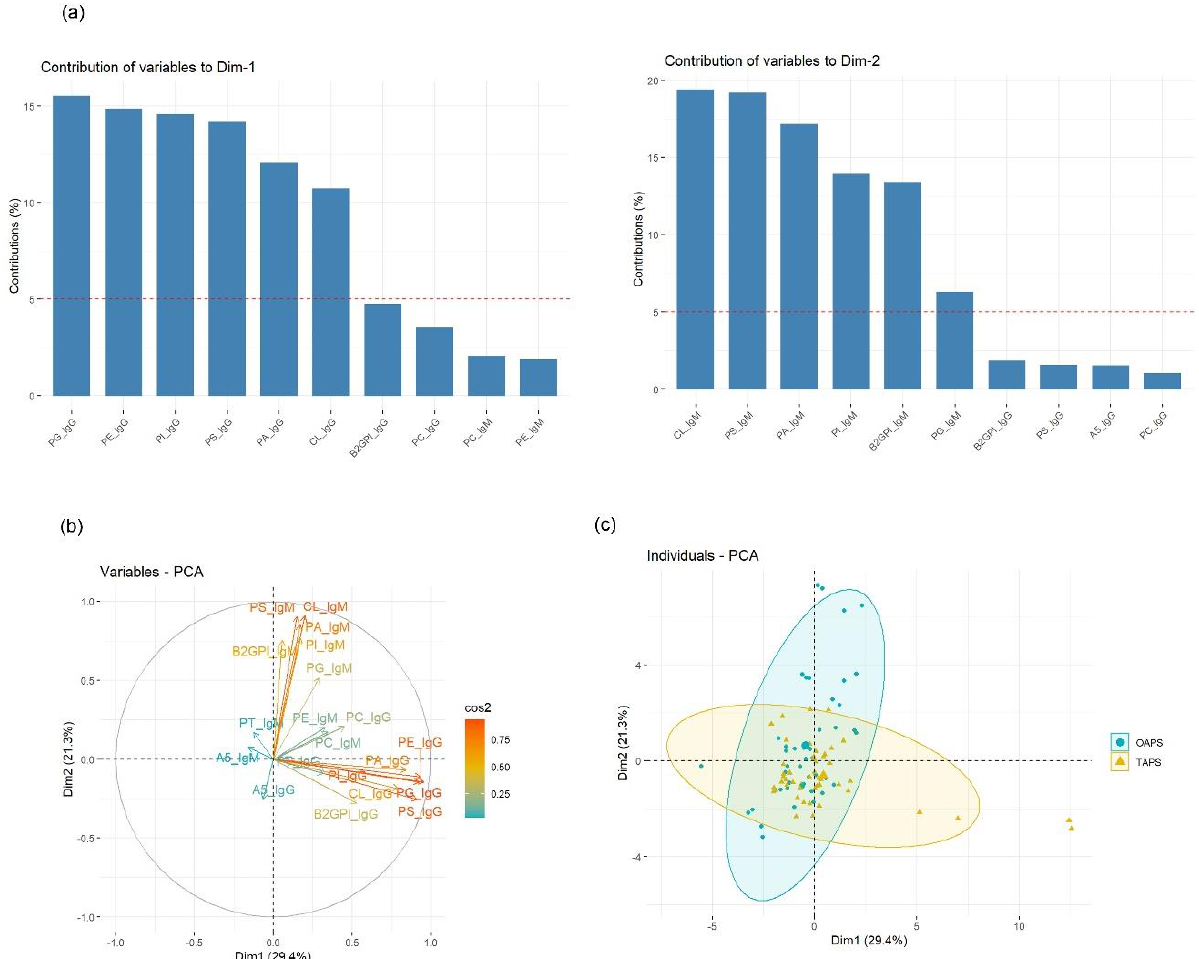
Figure 4. Antiphospholipid antibody (aPL) clustering for obstetric (OAPS) and thrombotic antiphos- pholipid syndrome (TAPS) patients. A principal component analysis (PCA) of logistic regression by using the R packages FactoMineR and factoextra was run. ( a ) The histograms show the selected variables and their value of contribution to define Dimension 1 ( x -axis) and Dimension 2 ( y -axis). ( b ) PCA bidimensional reduction resulting from using the defined Dimensions 1 and 2 and the degree of correlation (cos2) between the variables. ( c ) OAPS and TAPS patients plotted on this PCA based on their aPL levels. CL, anti-cardiolipin; PA, anti-phosphatidic acid; PI, anti-phosphatidylinositol; PC, anti-phosphatidylcholine; PE, anti-phosphatidylethanolamine; PG, anti-phosphatidylglycerol; PS, anti-phosphatidylserine; B2GPI, anti- β2 -glycoprotein-1; A5, anti-annexin 5; PT, anti- prothrombin.